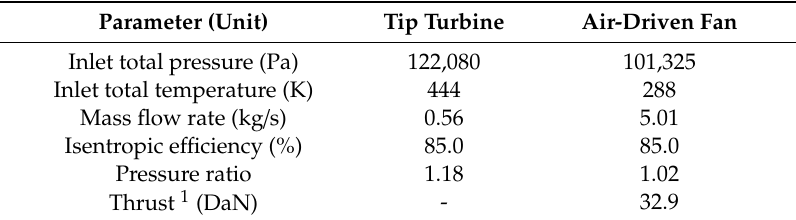
Table 1. Design parameters of the